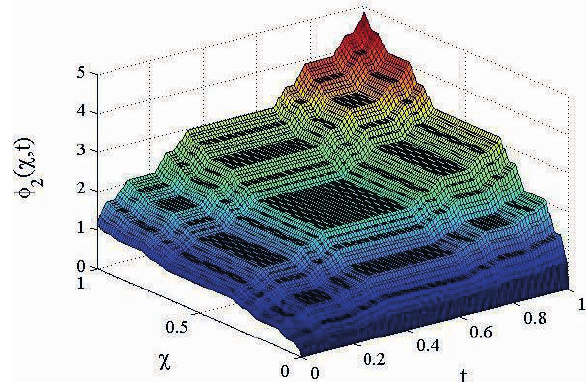
Fig. 2: Numerical simulation of second order approximation with non-differentiable terms when γ = ln2